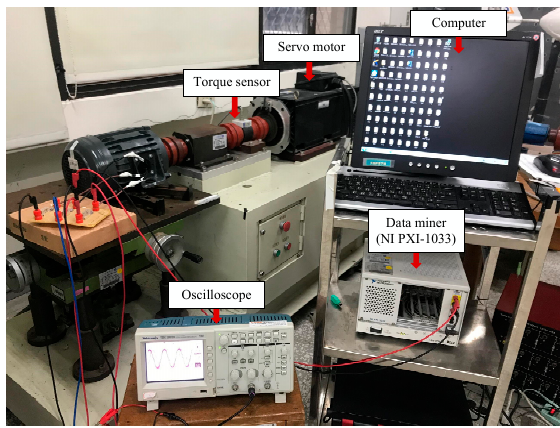
Figure 5. Torque sensor, servo motor, computer, oscilloscope, and data miner (NI PXI-1033).